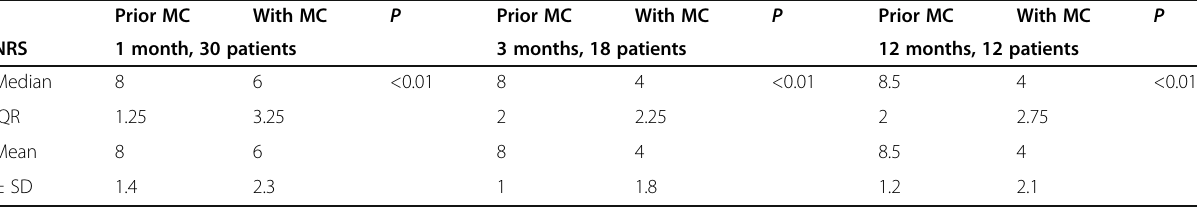
Table 6 The analgesic efficacy of medical cannabis therapy at 1, 3, and 12 months Prior MC